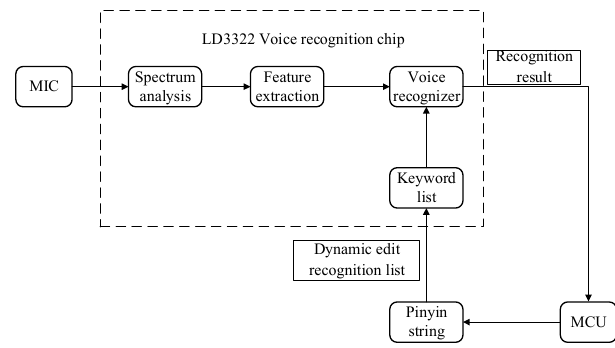
Figure 11. Schematic diagram of voice control.